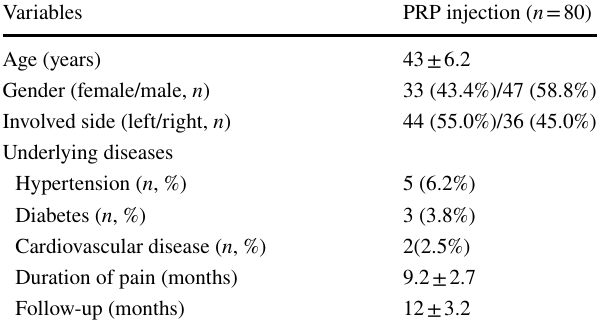
Table 1 Patient demographics and characteristics